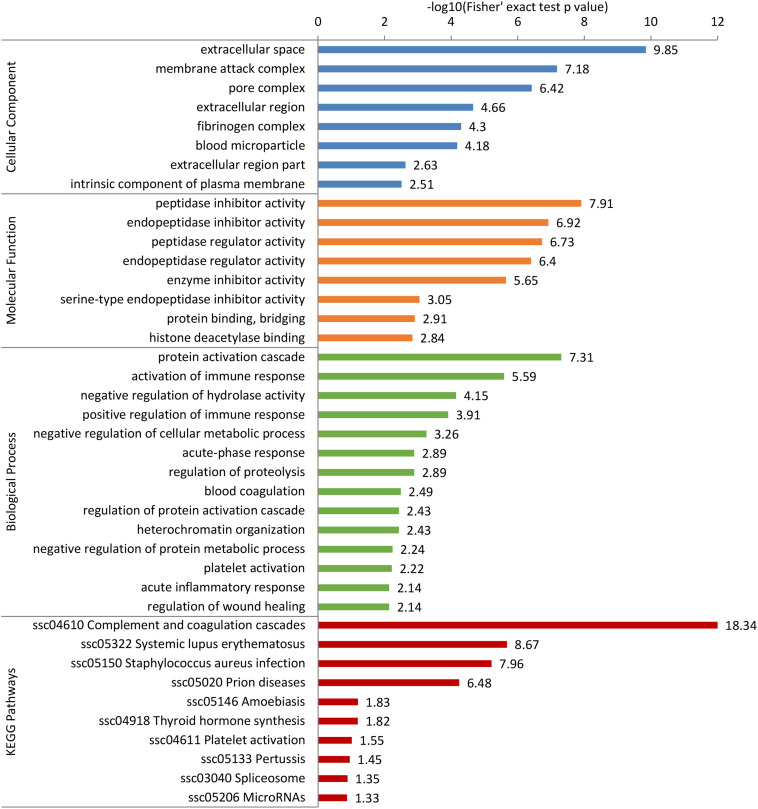
Gene Ontology (GO) and Kyoto Encyclopedia of Genes and Genomes (KEGG) pathway enrichment analysis of differentially expressed proteins (DEPs). The DEPs were enriched into cellular component, molecular function, biological process, and KEGG pathway. The bar represents the enrichment score associated with each term, and score value is shown as -log10 (Fisher’s exact test p-value).